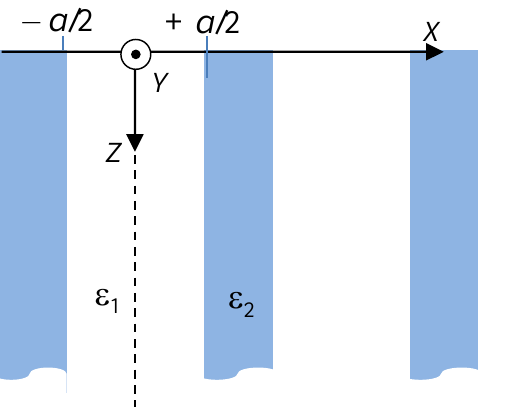
Figure A1. Schematic representation of the periodic MIM structure used in FMM calculations. The SP is excited by a TM polarized plane electromagnetic wave of angular frequency ω and wavelength in free space λ π c/ ω , incident normally onto the grating, i.e., in 0 = 2 Z -direction (see Figure 6a). The electric field E i and the magnetic field H i the incident wave are parallel to the X- and Y -directions, respectively. Since the X-component of the wavevector of the incident wave is zero, the excited SP waves could be expanded in harmonic components with propagation vector along X , multiple of 2 π / Λ . Therefore, the electric and magnetic field of the SP wave satisfy the periodic boundary conditions E ( x ) = E ( x + Λ ) and E ( x ) = E ( x + Λ ) , respectively. We assume that ω < ω p (the plasma frequency of the metal), which means that ε 2 < 0 and the electromagnetic field falls off exponentially inside the metallic